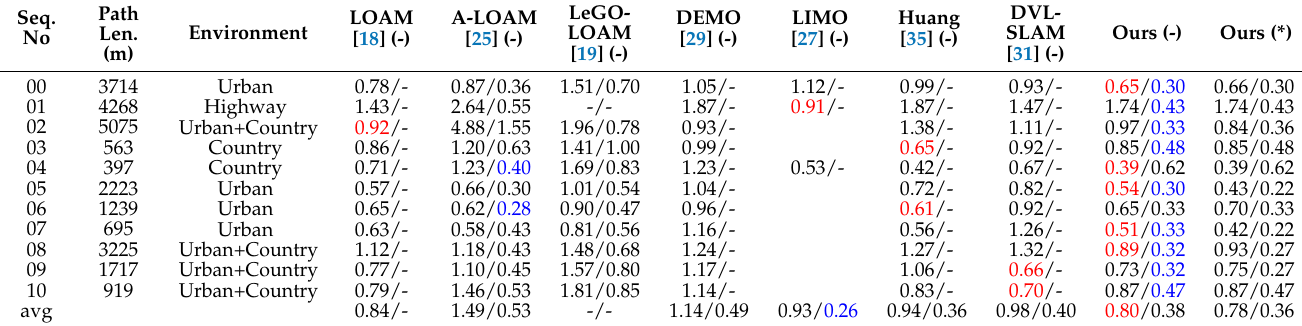
Table 2. Translation error [%]/rotation error [deg/100 m] comparison of the proposed DV-LOAM with existing methods on the whole KITTI training dataset, where (-) represents without using loop closure and (*) represents using loop closure. Best results of (-) in relative translational error/relative rotational error are highlighted in red and blue, respectively. Path Seq. Len. No